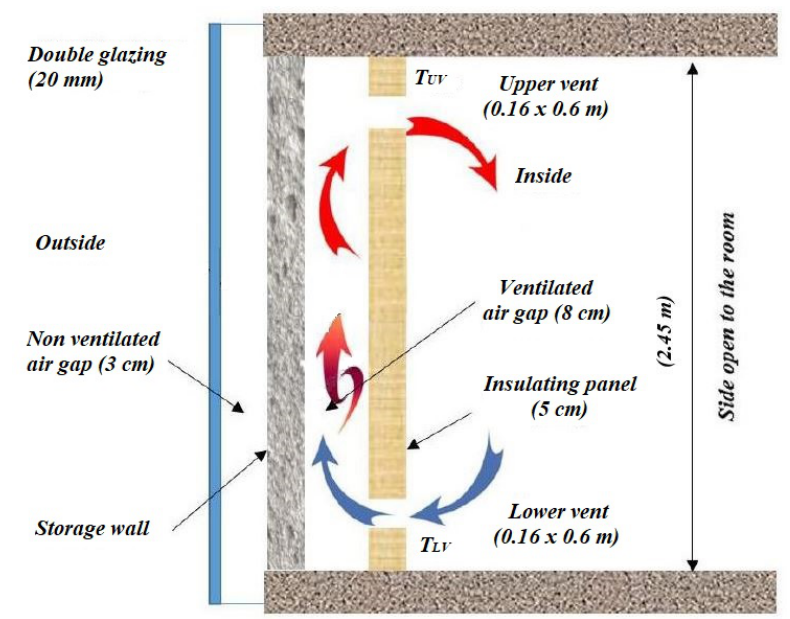
Figure 2. Vertical cross-section of the solar Trombe wall system.